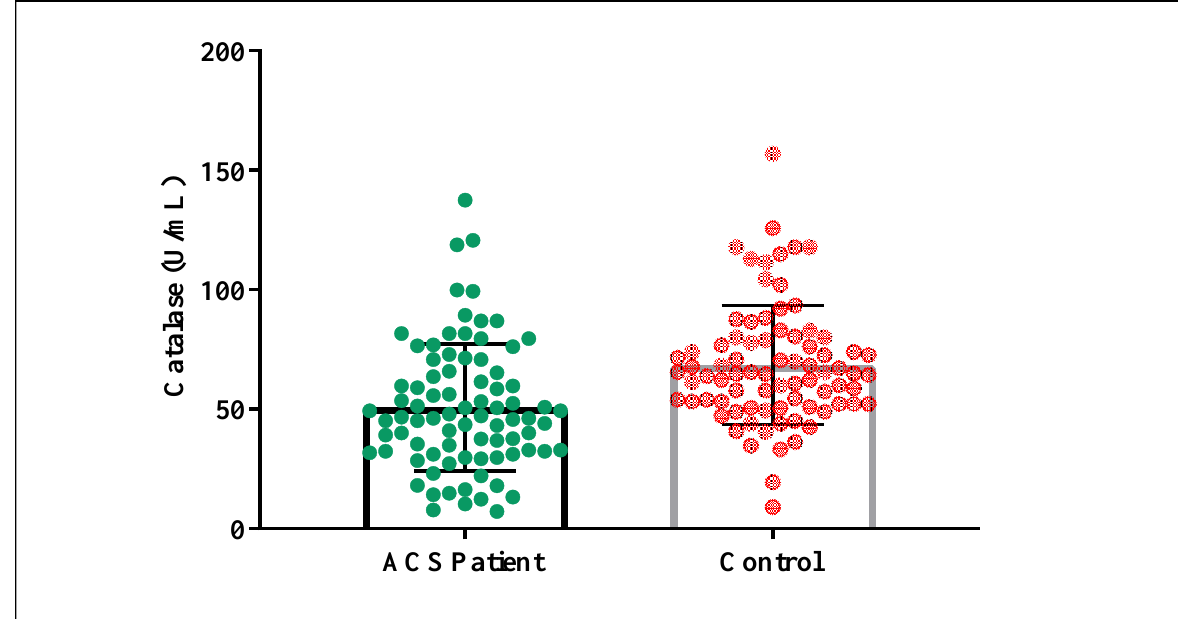
Figure 2: Comparison of serum catalase activity between the studied groups. The ACS patients had significantly lower catalase activity than the controls ( p < 0.001, Mann-Whitney U test)